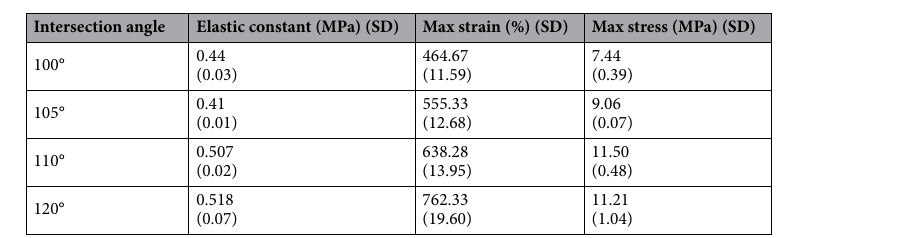
Table 1. Mechanical performance of the stretchable cylindrical textile interconnection for each intersection angle between fibers. The values in the table are average ones measured from 6 samples with same process. The number in parenthesis is standard deviation value. SD, Standard